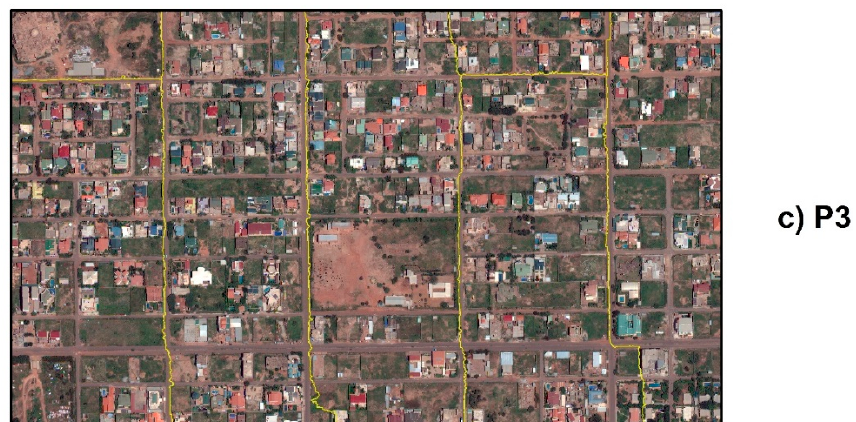
Figure 3. Partitioning the WorldView-3 image into spatial subsets for local USPO optimization. ( a ) Delineation by 0.250 km 2 area tiles, ( b ) delineation by 0.125 km 2 area tiles and ( c ) delineation based on zero crossing cutline